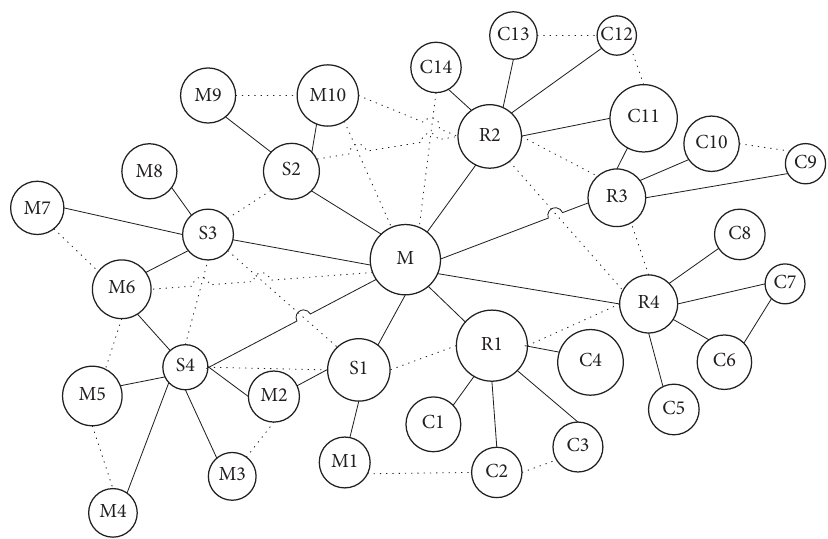
Figure 1: Supply chain relationship